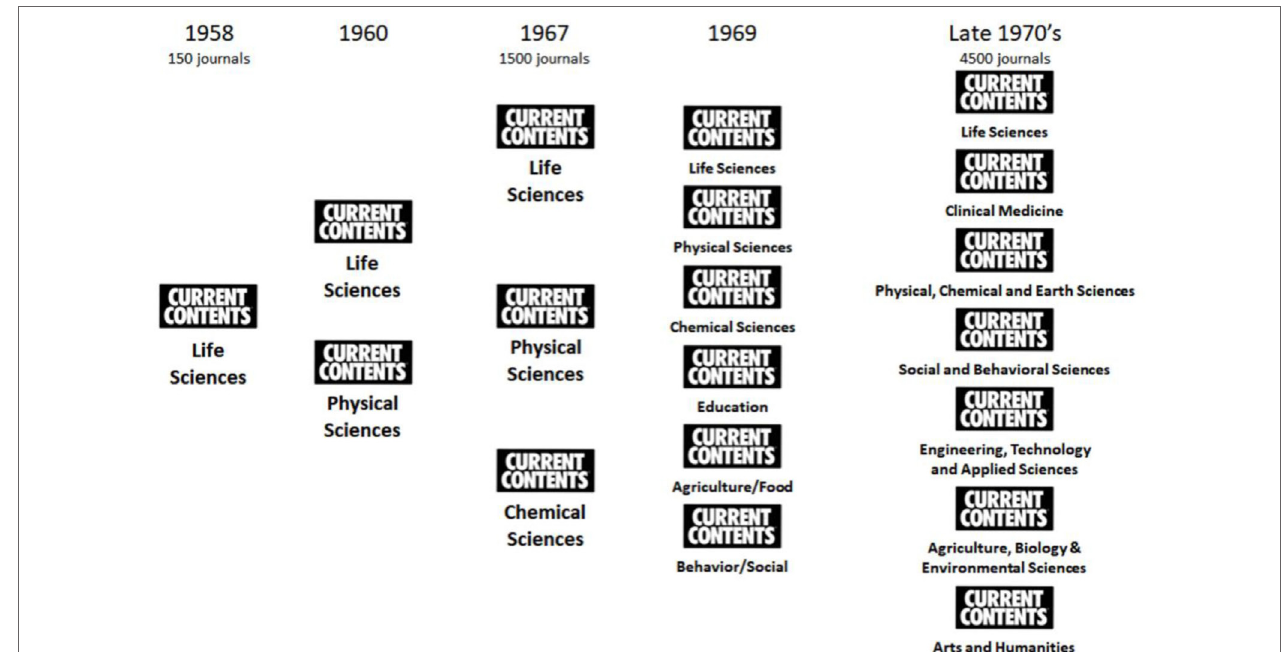
FiGURE 1 | The growth of Current